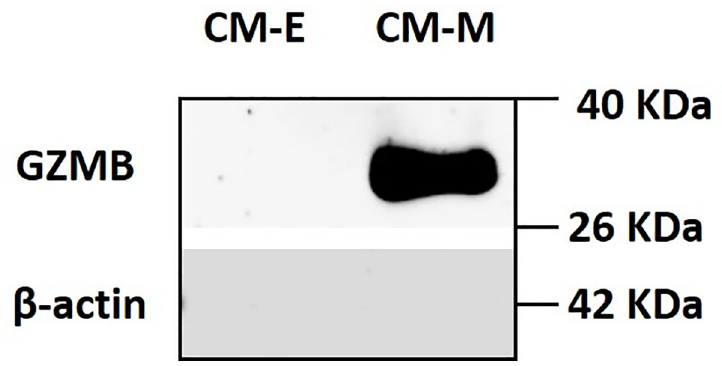
ARCaP-M conditioned media (CM-M). These results show the high level of GZMB secretion by ARCaP-M.